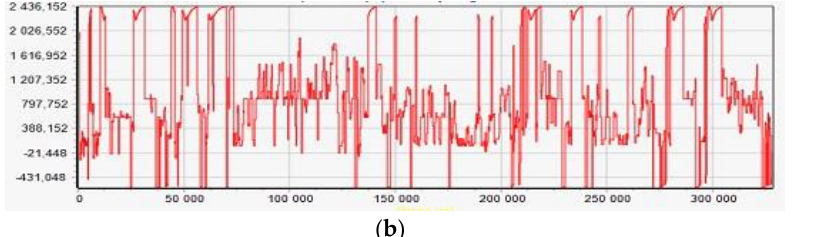
Figure 10. Current drawn by trains on the TI route-direction of movement W-Gd ( a ) ED250 and ( b ) PAS. Source: developed by the authors-results of simulations.